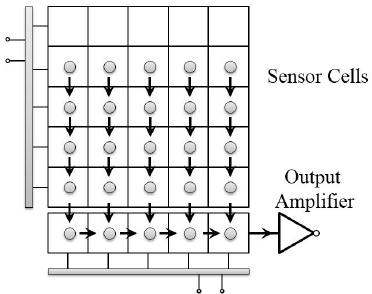
Figure 2. CCD readout phase. Charges are handled row by row to generate the final image through the vertical transfer, horizontal transfer, voltage conversion and amplification